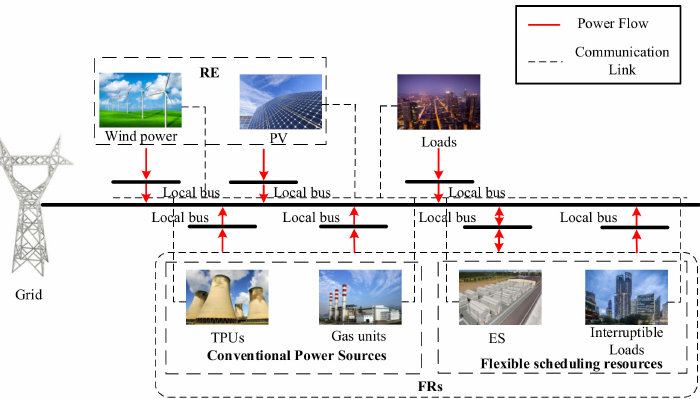
Figure 2. Structural diagram of the overall